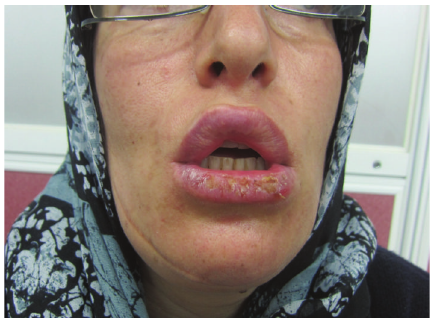
Figure 1: Scaly crusted lesions on lower lip (before biopsy).